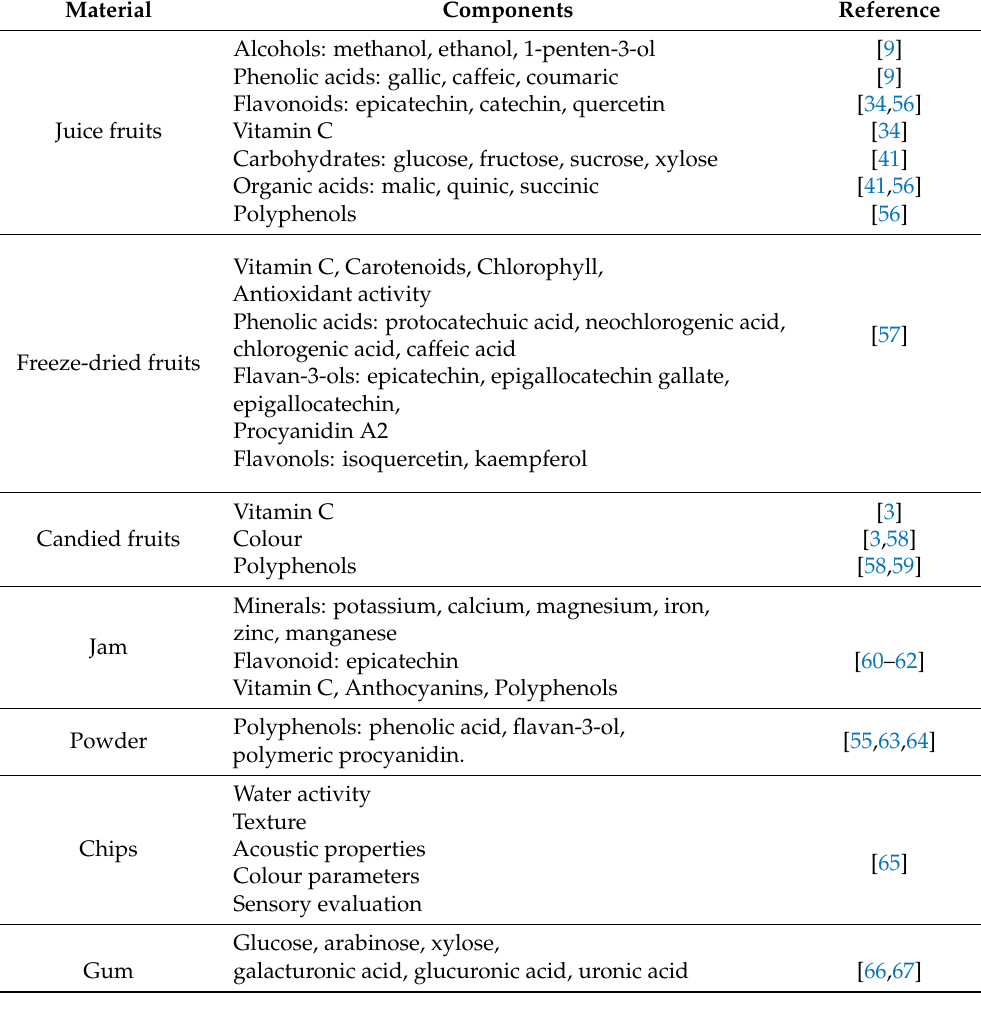
Table 2. The presence of selected compounds in processed Chaenomeles sp.